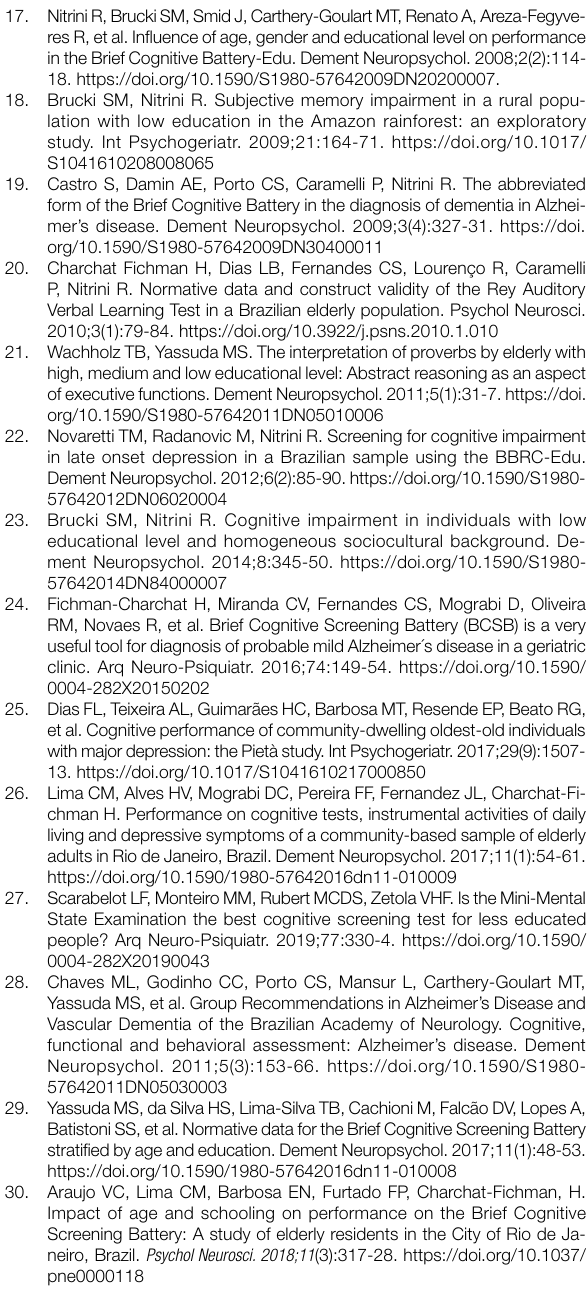
The Figure Memory